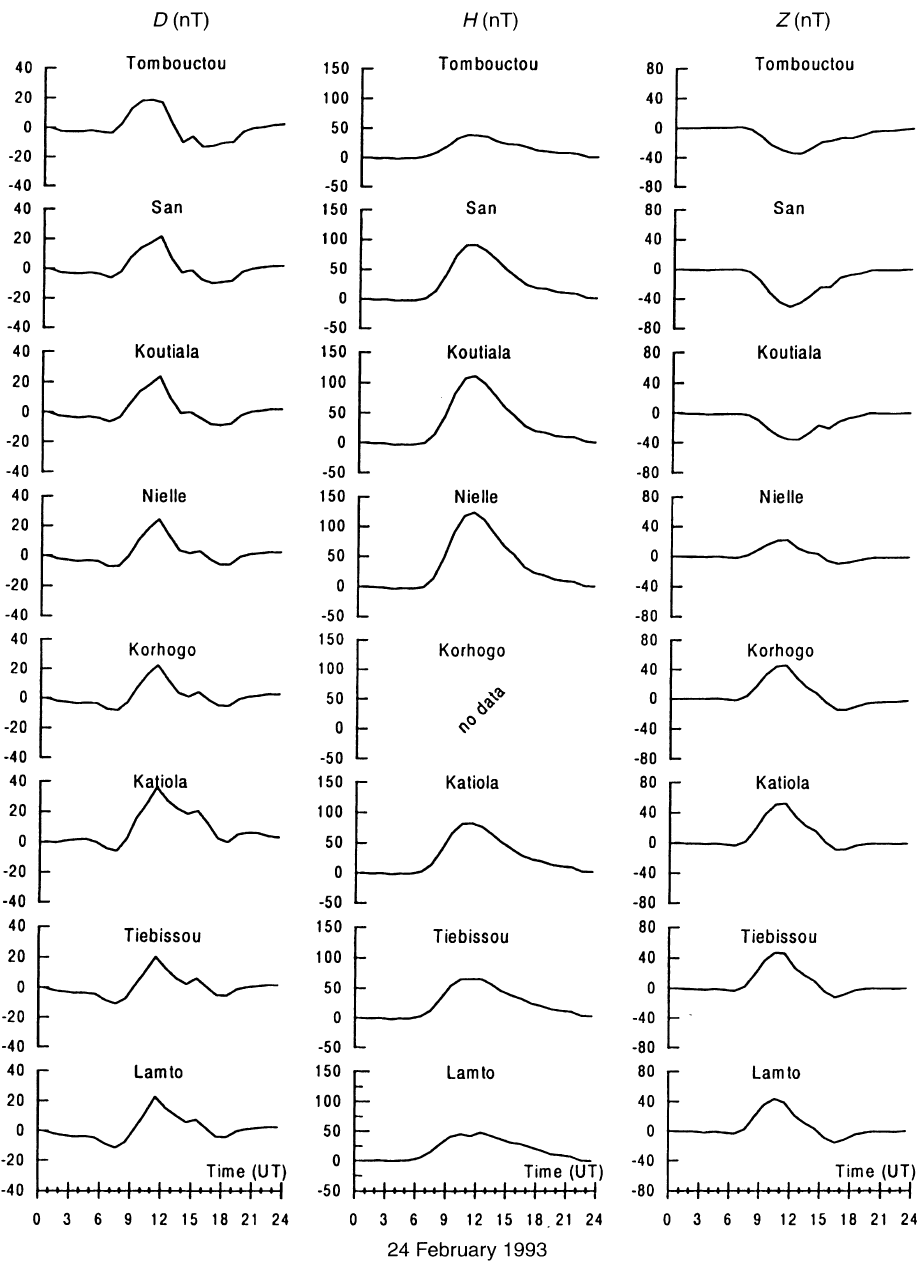
Fig. 4. Diurnal variations of hori- zontal (east D , north H ) and vertical Z components of the magnetic field recorded at eight stations of the profile on 24 Feb-